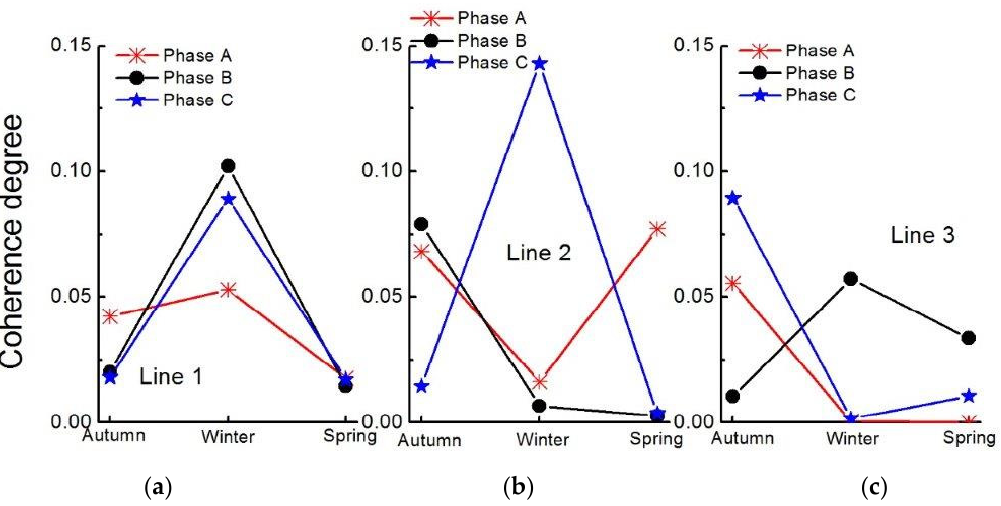
Figure 4. Coherence degree between each current signal and a generic sinusoid (as a reference), PC ref , for each phase of each distribution circuit for the different seasons. ( a ) L1; ( b ) L2; and, ( c ) L3.